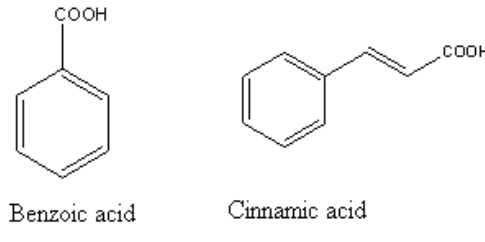
Figure 5. Two phenolic allelochemicals for cucumber bioassays [37].